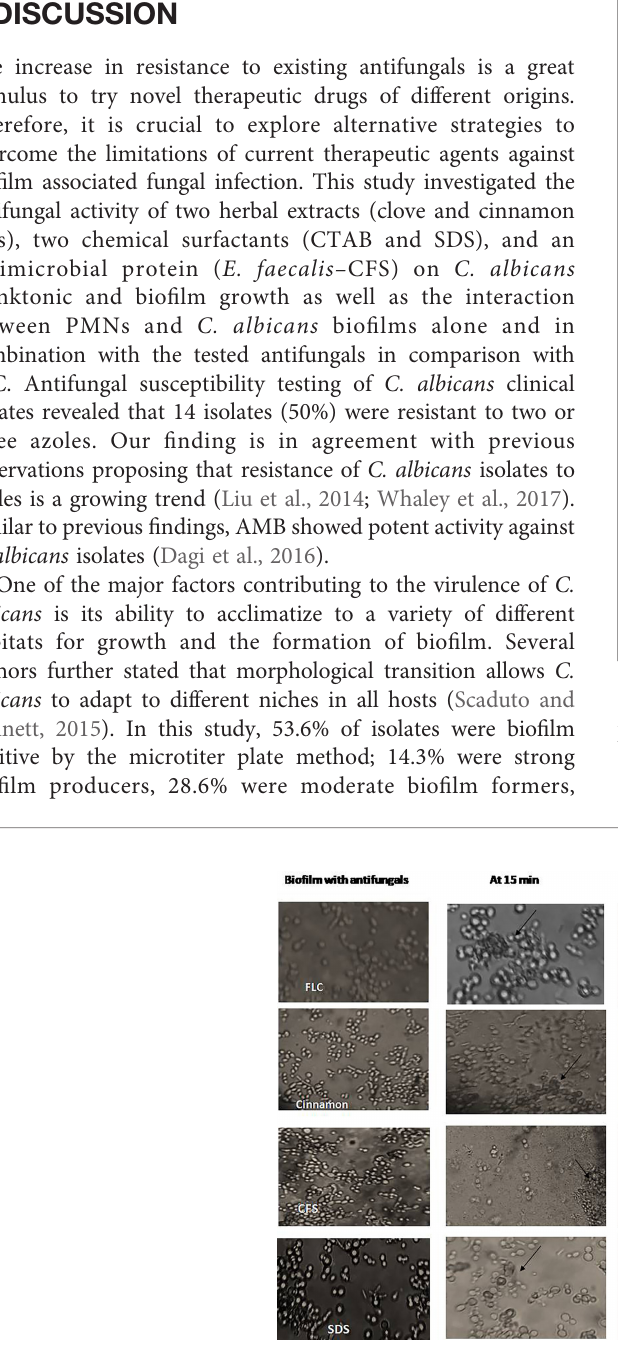
FIGURE 3 | Interaction between peripheral blood leukocytes (PBLCs) and C. albicans bio fi lms formed in the presence of the tested agents (in bio fi lm inhibition testing): fl uconazole, cinnamon oil, E. faecalis – CFS, and sodium dodecyl sulfate (SDS). Fluconazole (1,024 µg/ml) – treated bio fi lm was resistant to phagocytic cells. Meanwhile, in cinnamon (1 µg/ml) – , E. faecalis – CFS (1 µg/ml) – , and SDS (0.62%) – treated bio fi lms, the phagocytic cells were able to clean and engulf Candida cells. The phagocytic cells showed a considerable activity against C. albicans bio fi lm formation in the presence of E. faecalis – CFS (×400, scale bar = 40 µm). In another set of experiments PBLCs were added to planktonic cells. Both C. albicans bio fi lm with antifungals and planktonic cells were kept as controls. Arrows refer to